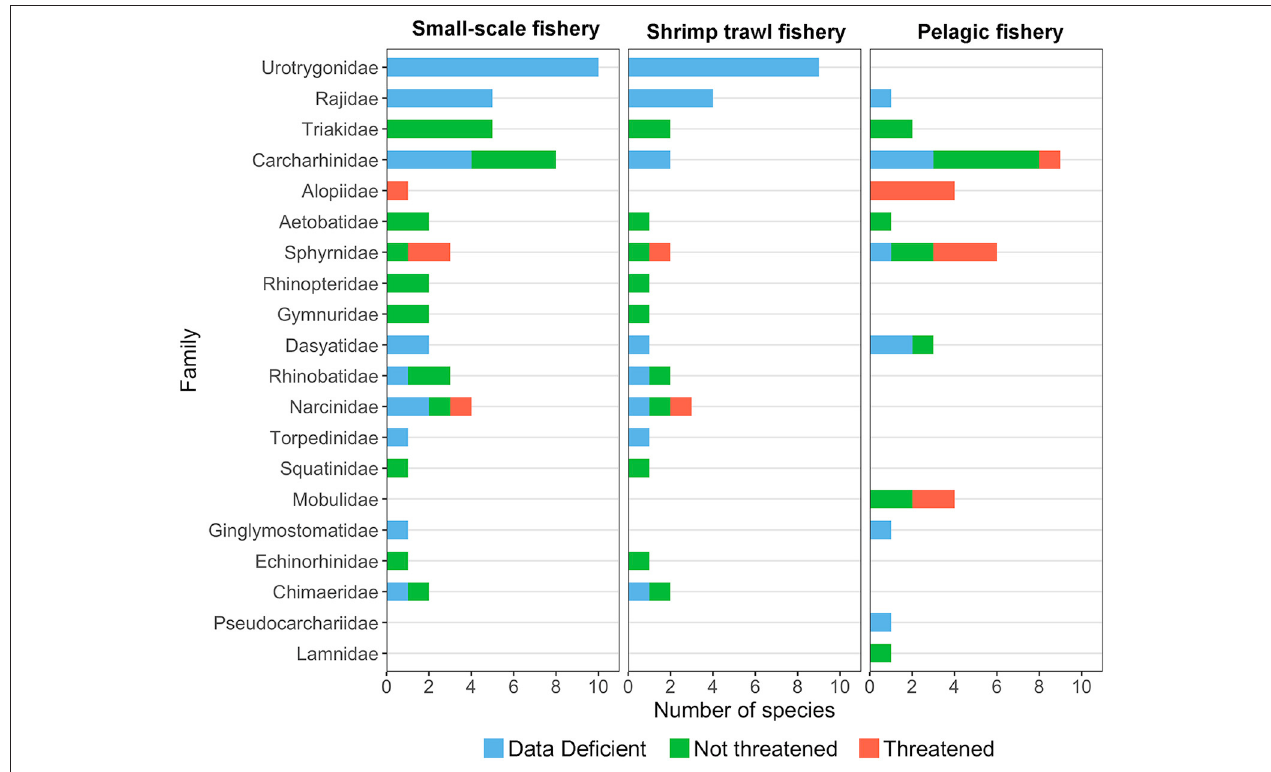
FIGURE 4 | Number of species per family captured by small-scale, trawl, and pelagic fisheries in Costa Rica. Data deficient and not assessed species are represented in blue, non-threatened species are represented in green and threatened species are represented in red (IUCN Red List categories). Species catch data were obtained from the following studies: Arauz et al. (2007), Benavides et al. (2014), Bystrom (2015), Campos (1986), Clarke et al. (2016), Dapp et al. (2013), López-Garro et al. (2009) , López-Garro and Zanella (2015), Rojas et al. (2000), and Whoriskey et al.